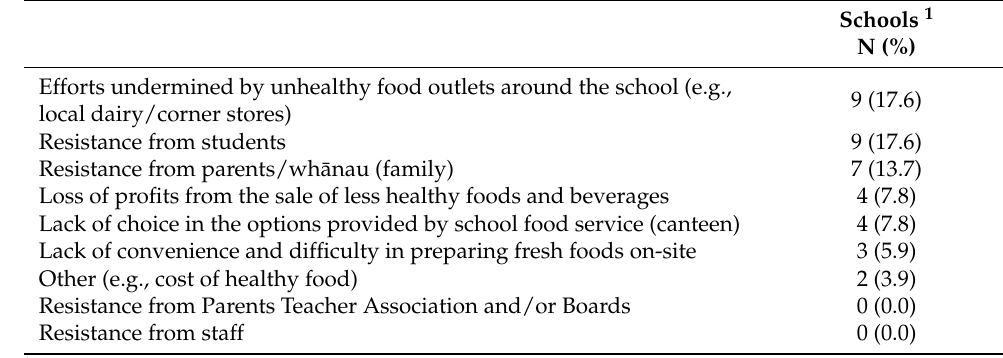
Table 5. Barriers to implementing a healthy food and nutrition environment in Hawke’s Bay